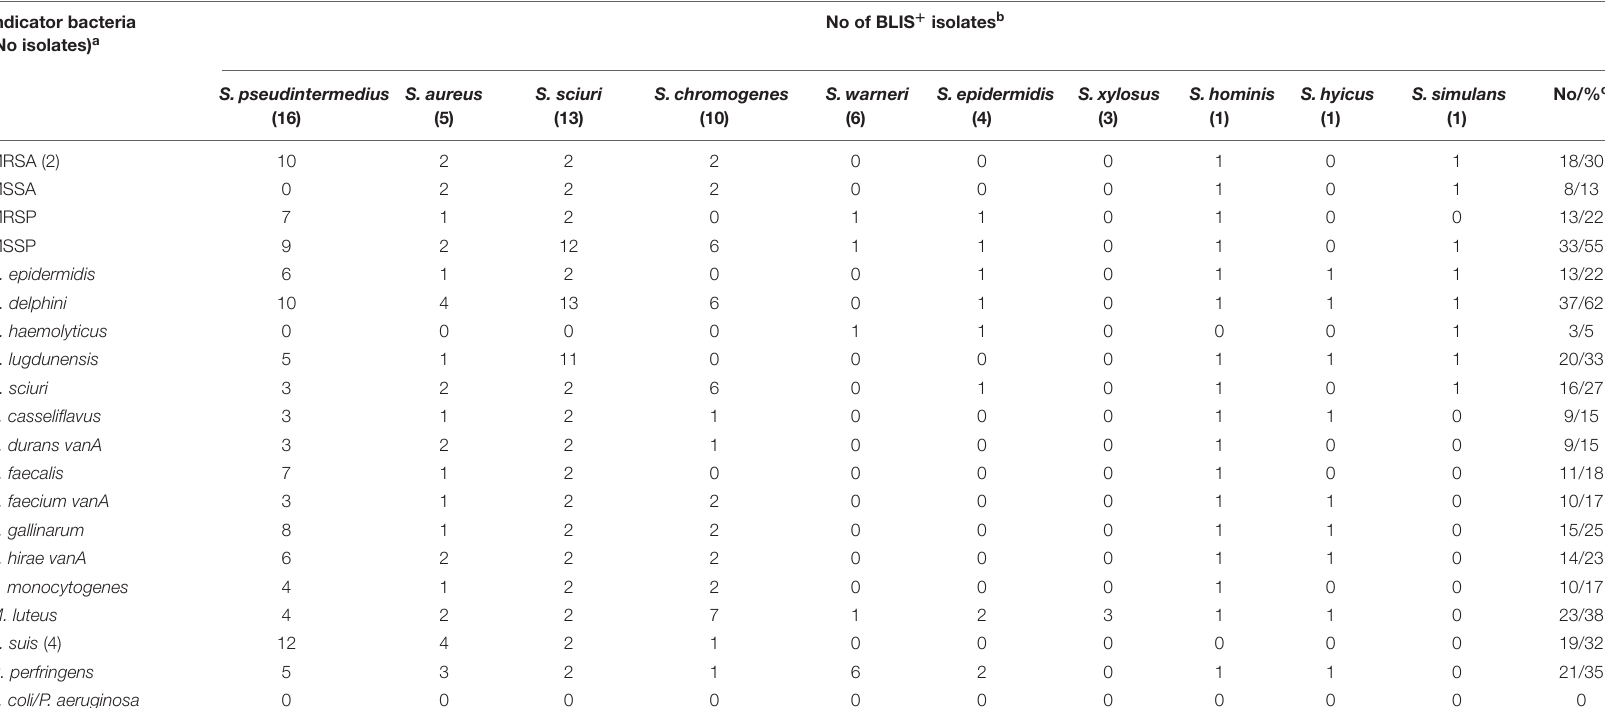
TABLE 3 | Antimicrobial activity of the 60 bacteriocin-like inhibitory substances producer (BLIS + ) isolates against 25 indicator bacteria. Indicator bacteria (No isolates)